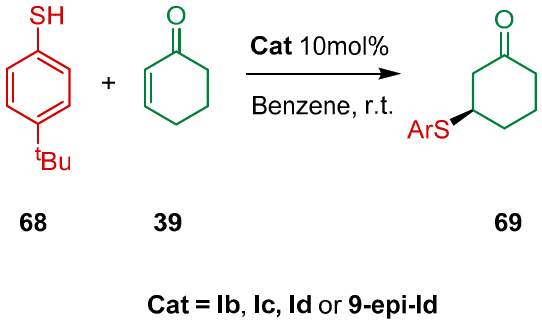
Scheme 29. Enantioselective 1,4-addition of thiols to unsaturated